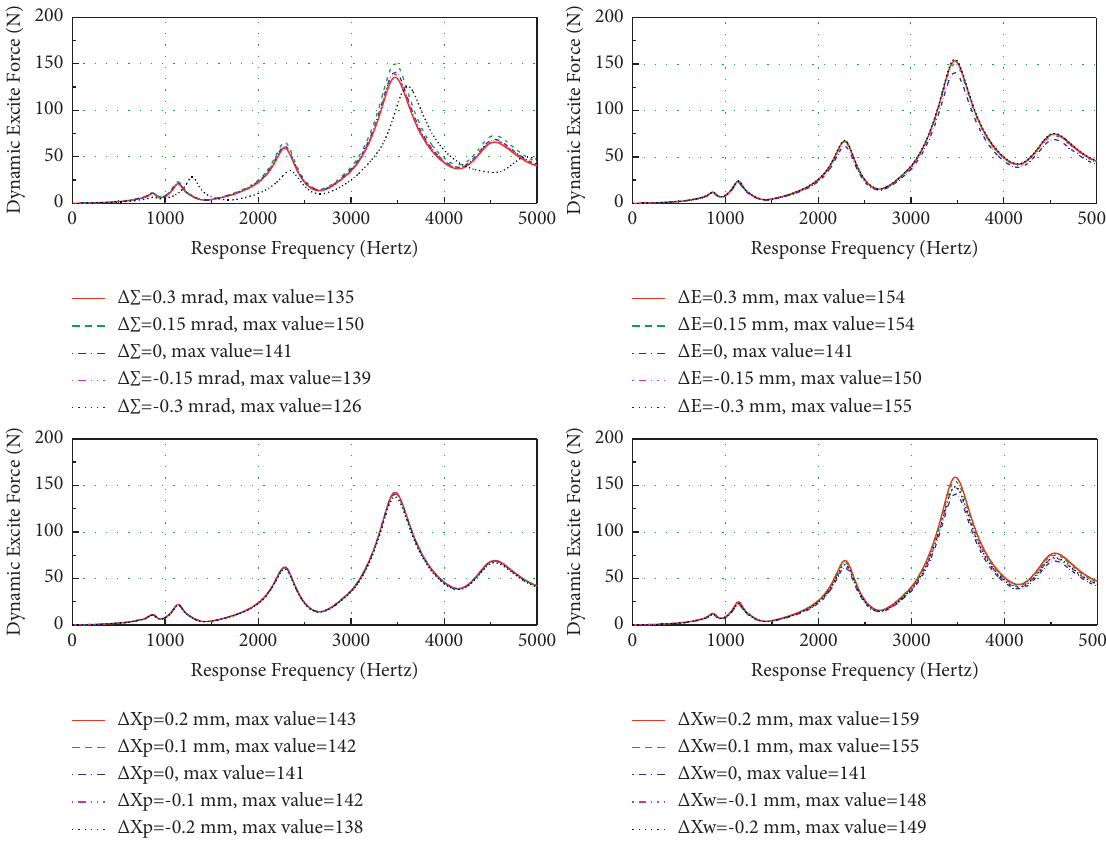
Figure 14: Dynamic excite force in frequency